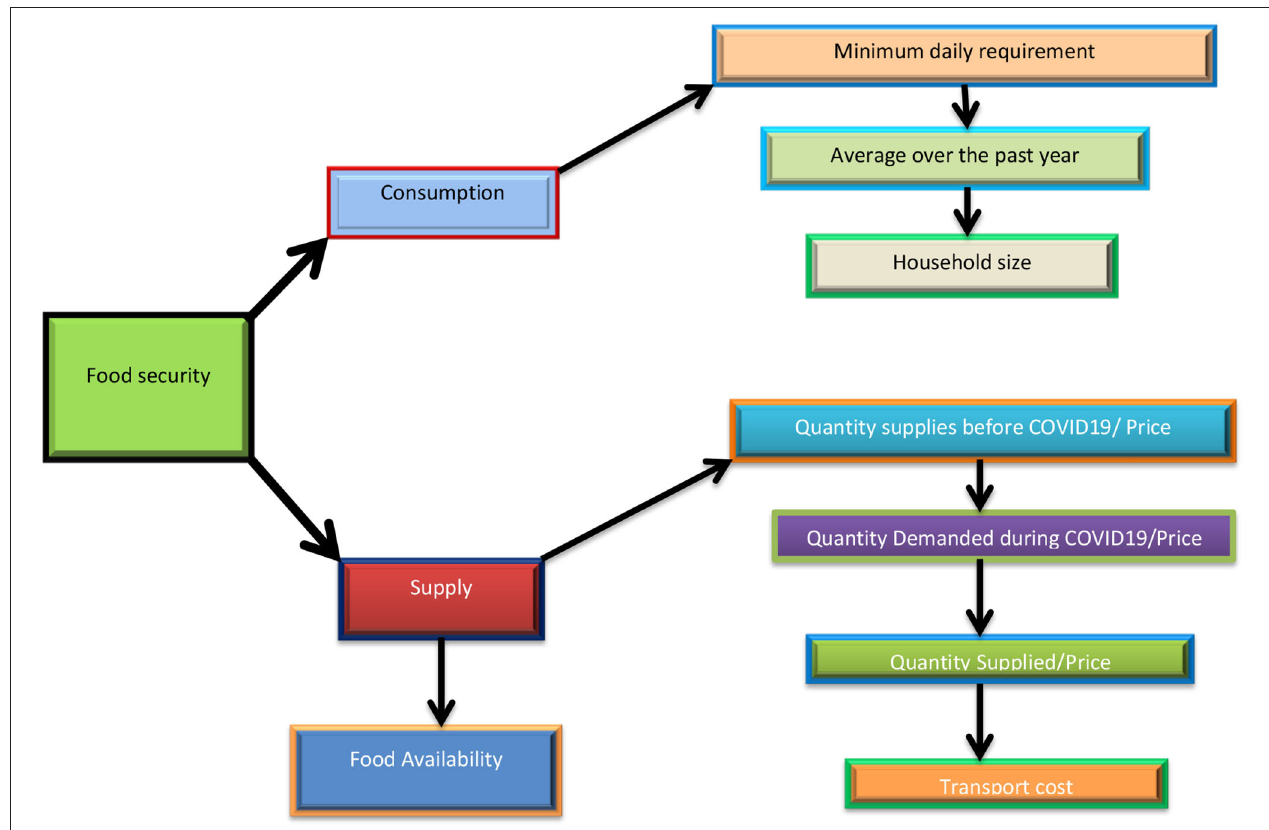
FIGURE 1 | Structural framework, food security, and COVID-19 pandemic. Source: Munonye,